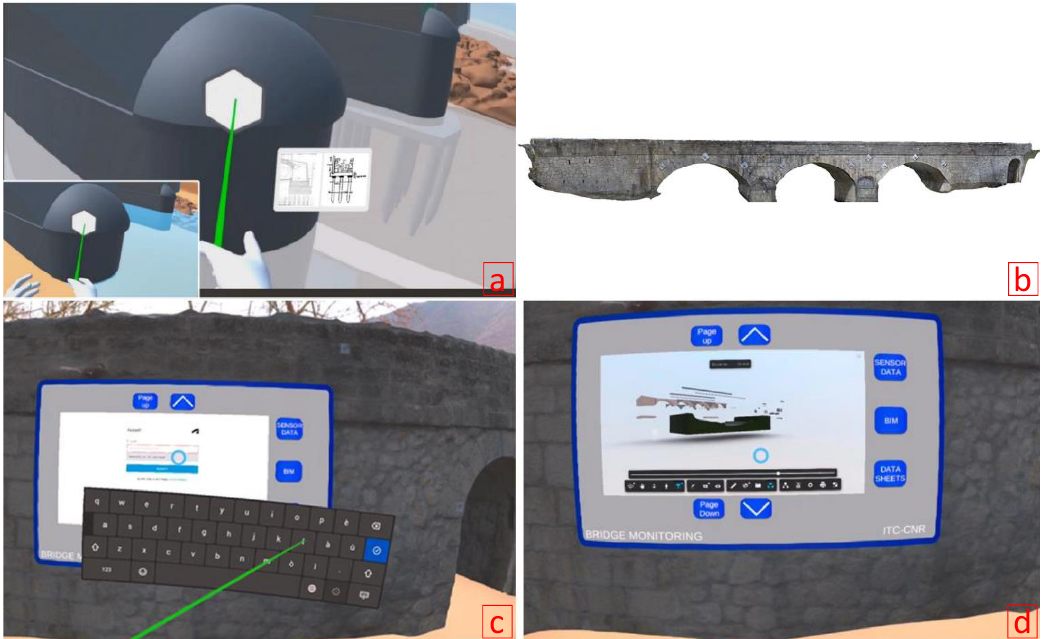
Figure 15. ( a ) VR of non-visible bridge components and related information that clarifies the structure; ( b ) photogrammetry model of the bridge; ( c , d ) visualization and query in the VR environment of the BIM model [105].